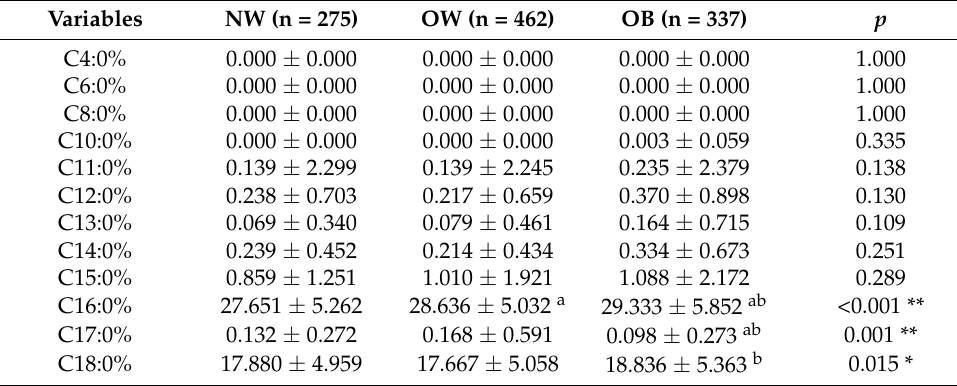
Table 4. The fatty acid composition of the erythrocyte membranes of the study population in the three